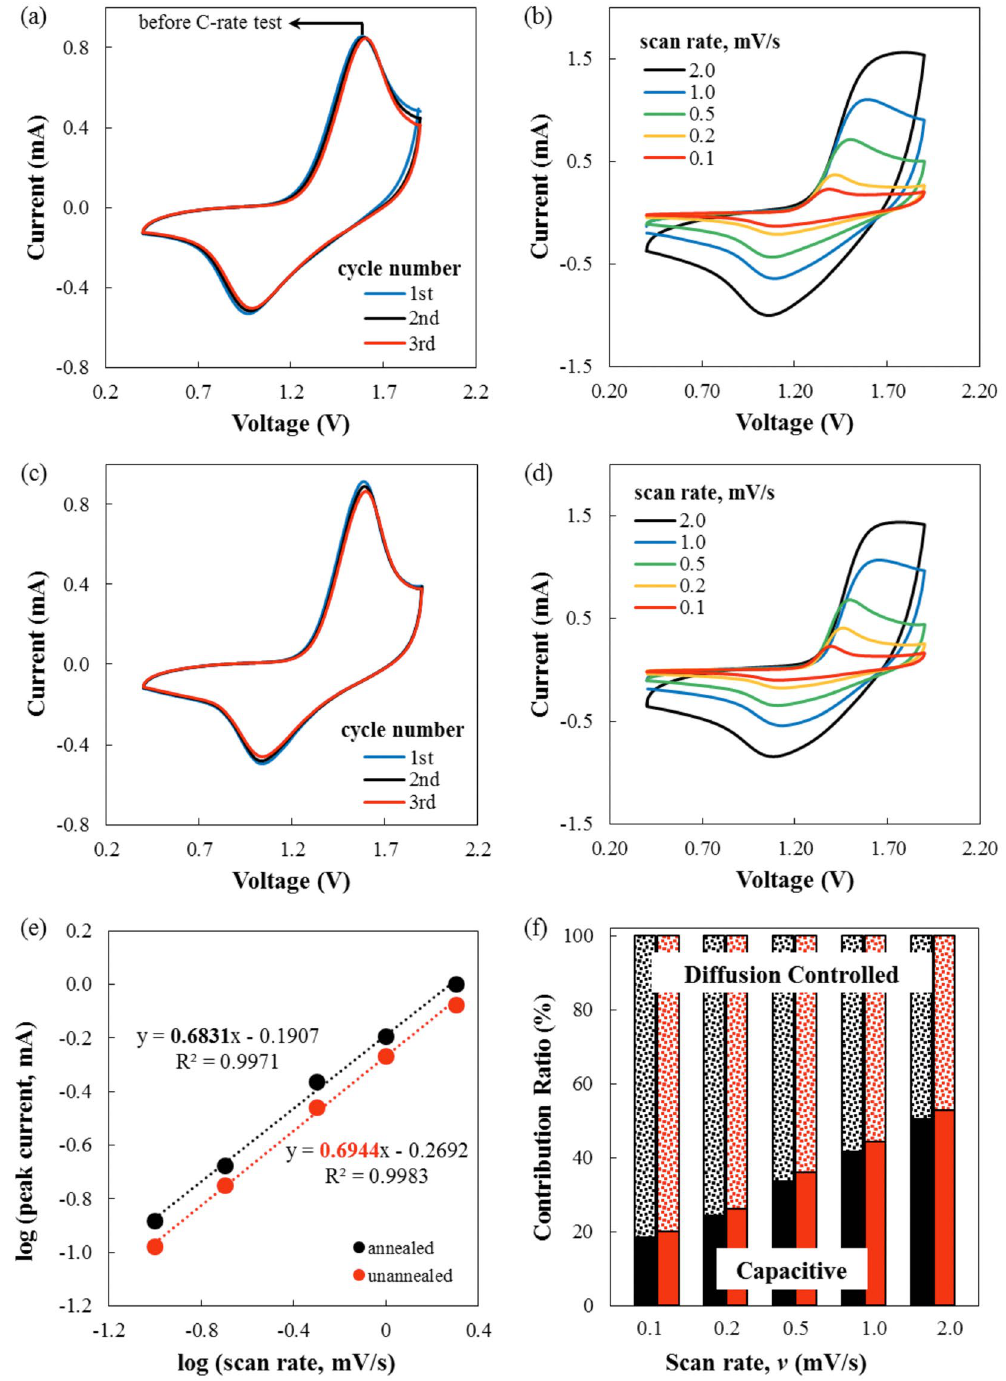
Figure 7. ( a – d ) Cyclic voltammogram of the ( a , b ) annealed and ( c , d ) un-annealed samples within the voltage window: (0.4–1.9) V vs. Zn/Zn 2 + using (a,c) 0.5 mV/s scan rate and ( b , d ) multiple scan rates. ( e ) log ( i ) vs. log ( v ) of the cathodic peaks of both annealed (red) and un-annealed samples (black). ( f ) Contribution ratio of capacitive and diffusion-controlled capacity at different scan rates for both annealed (black) and un-annealed (red)